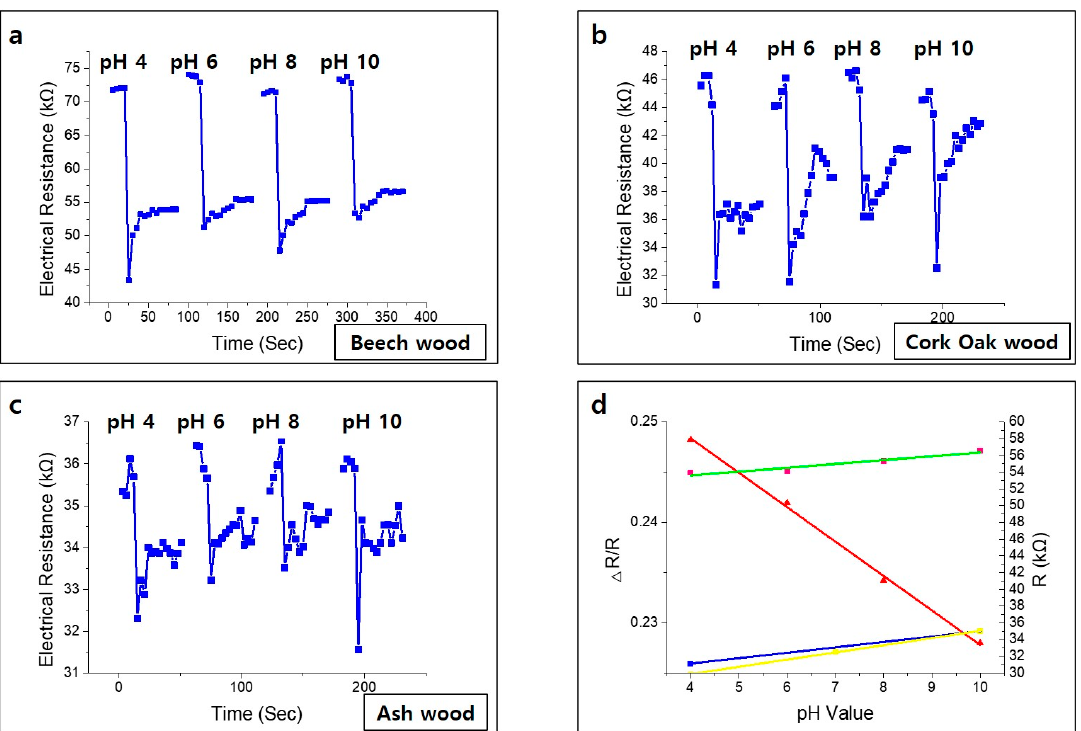
Figure 9. Change of sensor electrical conductivity according to pH value with a single buffer drop test; ( a ) beech wood, ( b ) cork oak wood, ( c ) ash wood, ( d ) investigation of linearity of changes in electrical properties of beech wood-based and changes in electrical resistance of each sensor according to pH value.